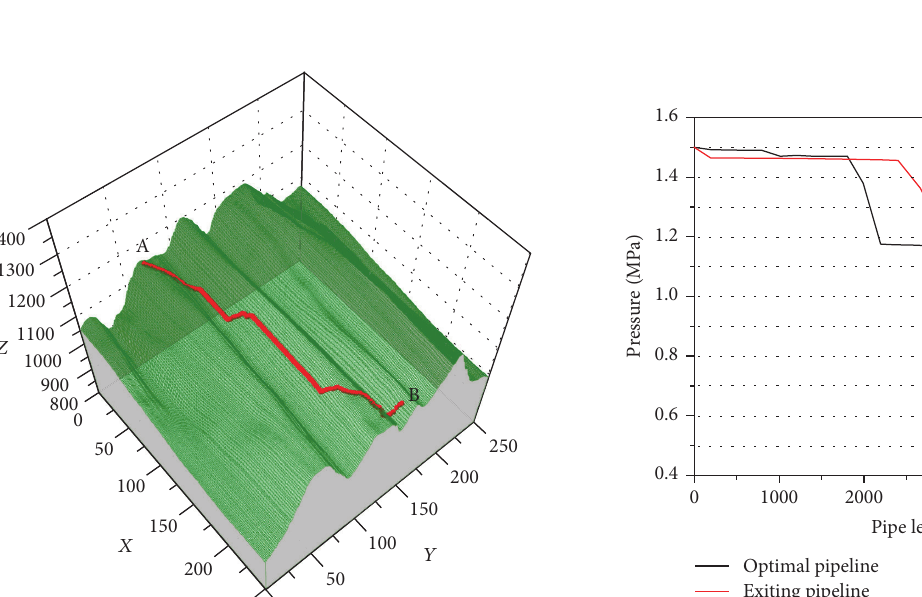
Figure 14: Elevation along the line.